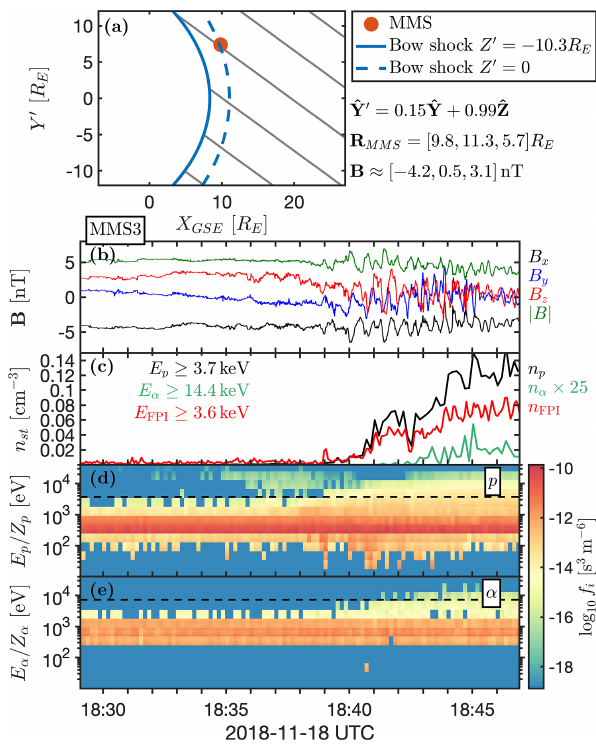
Figure 4. MMS3 crossing from the solar wind into the foreshock on 18 November 2018. The format is the same as in Fig. 3 but with He 2 + multiplied by